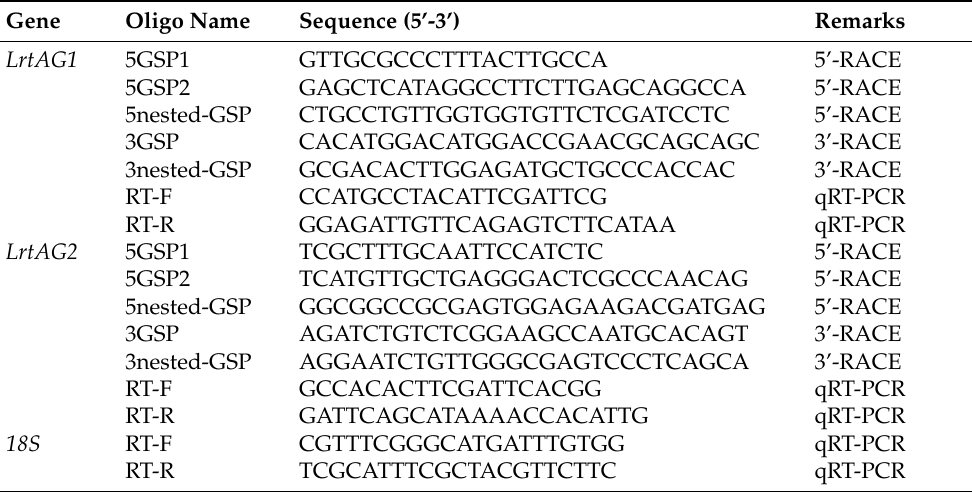
Table 1. Primers for rapid amplification of cDNA ends (RACE) and real-time quantitative PCR (qRT-PCR).